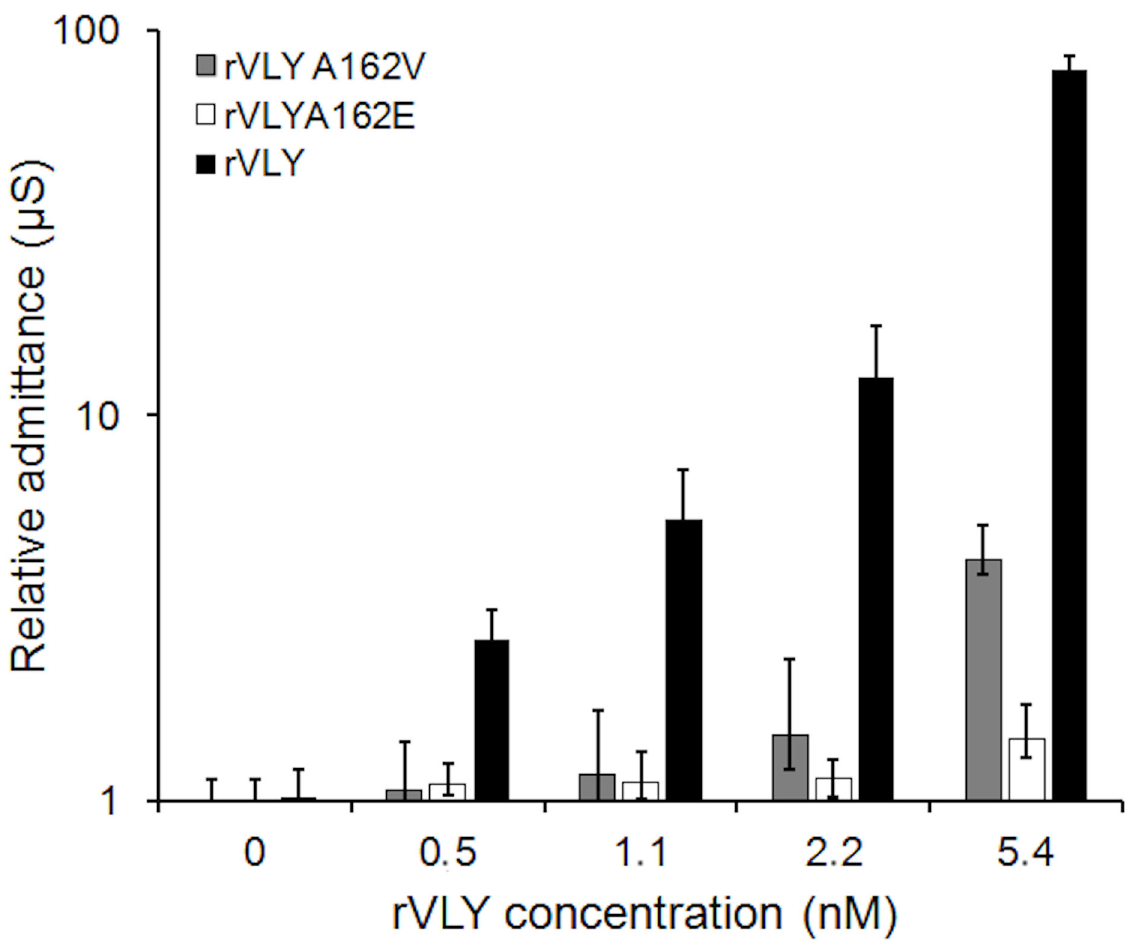
Figure 3. Admittance change of DOPC/CHOL40% tBLMs by different variants of VLY: rVLY (black bars), rVLY mutants A162E (white bars) and A162V (grey bars). Exposure time 30 min. doi: